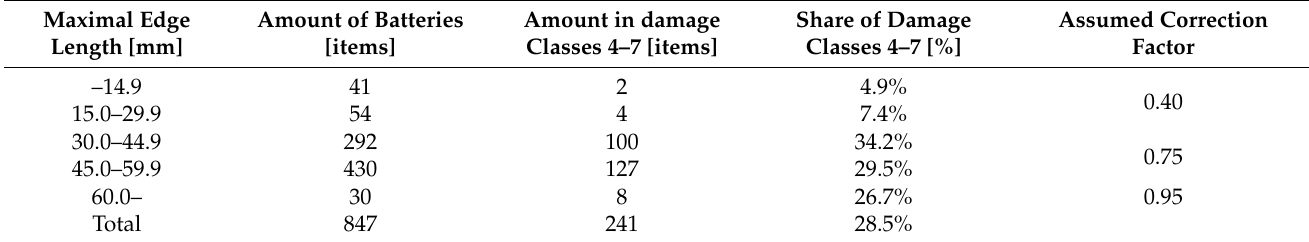
Table 6. Distribution of maximal edge length of the investigated portable